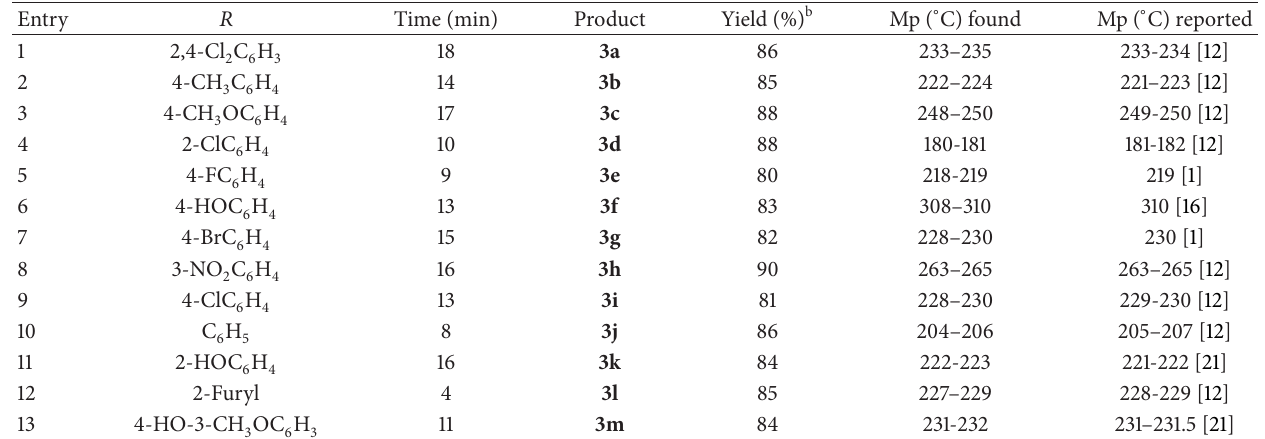
Table 2: Diammonium hydrogen phosphate catalyzed synthesis of 5-arylidenerhodanines a